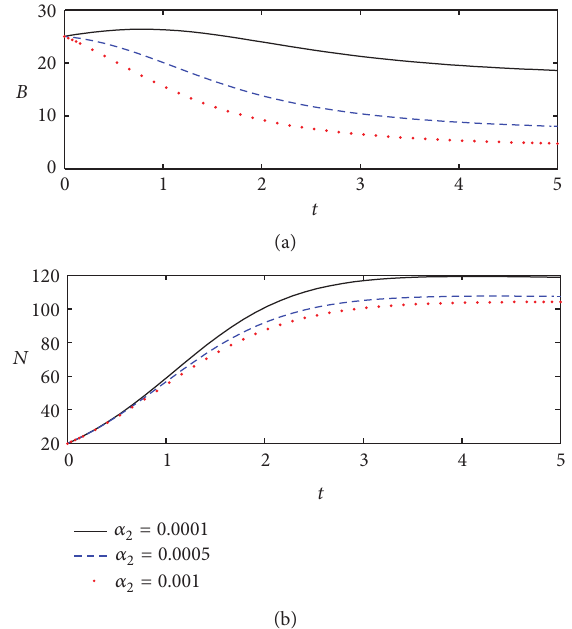
F 3: Plot of and with respect to time , and other values of parameters are the same as given in of 𝐵𝐵 𝑁𝑁 𝛼𝛼 2